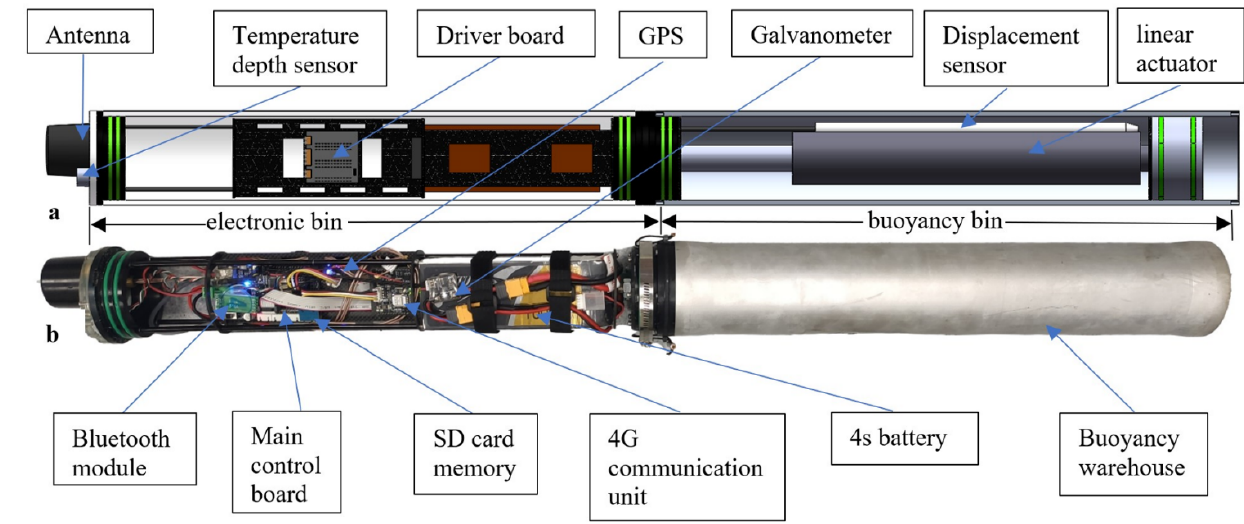
Figure 1. Hardware composition and layout of the float.